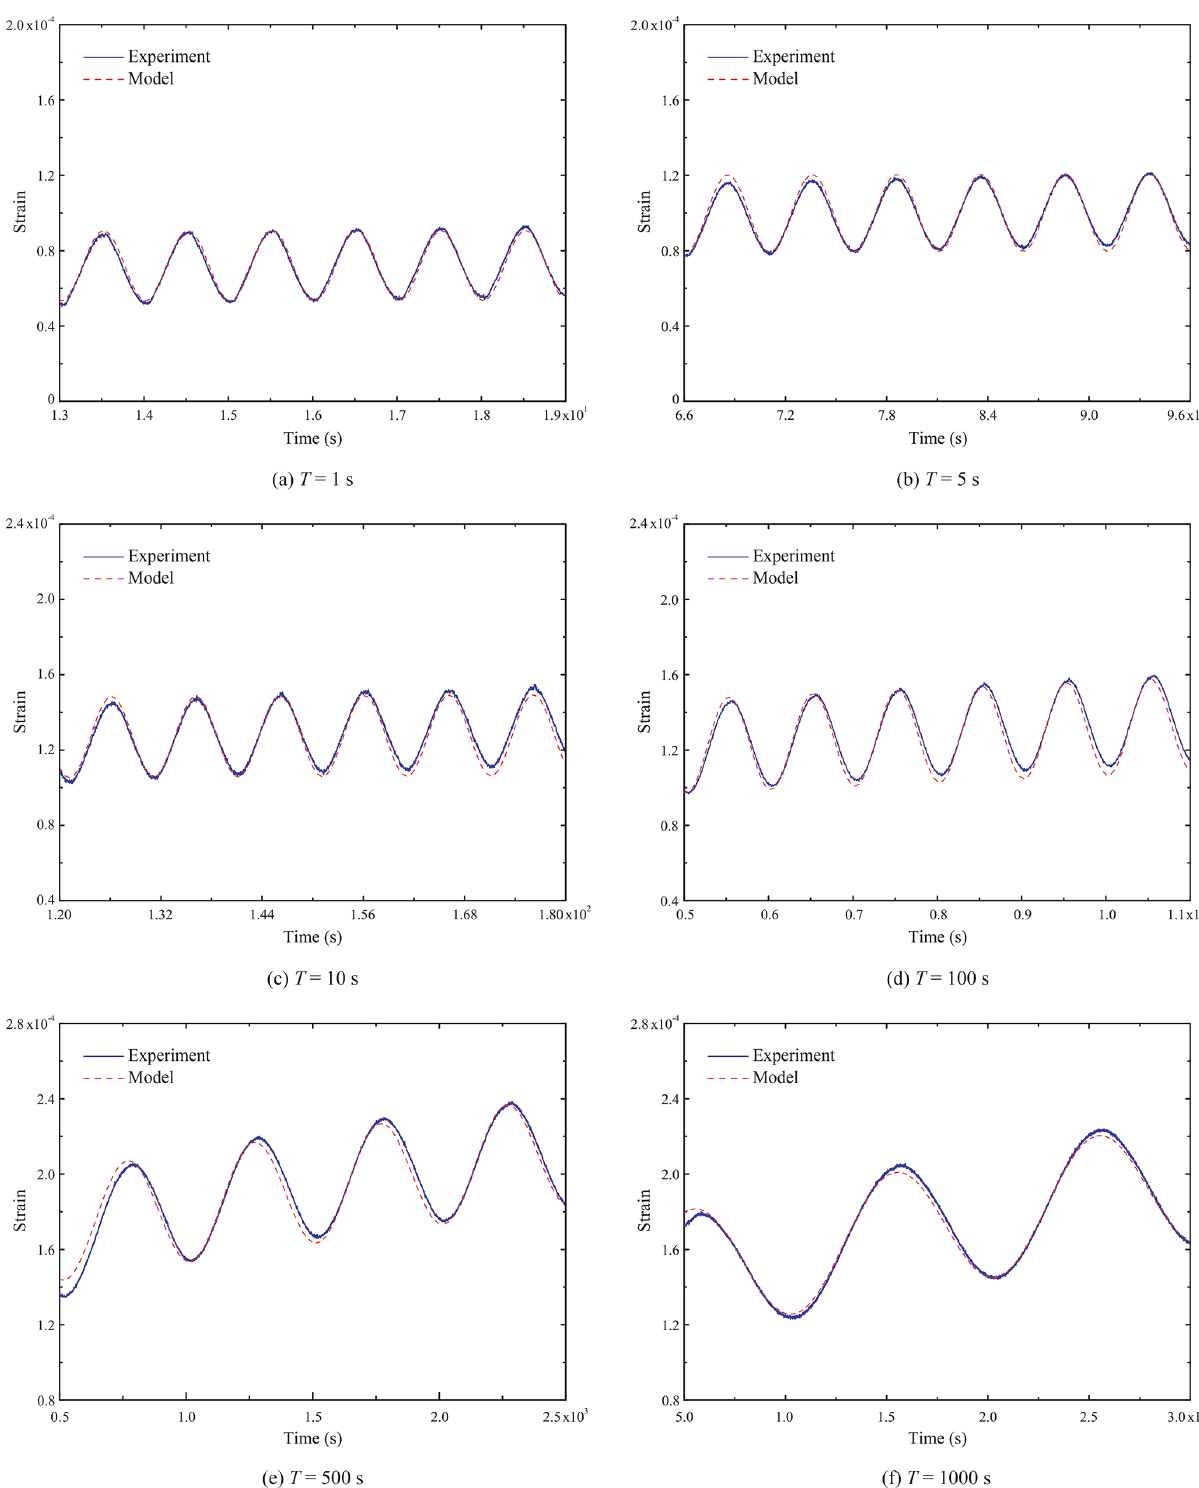
Figure 12. Comparison between the experimentally measured strain-time curves (in the steady stage) and the results yielded by the physically based model for specimen Dry-5ppt-1, tested with stresses varying from 0.08 to 0.25MPa and with a temperature of − 10 ◦